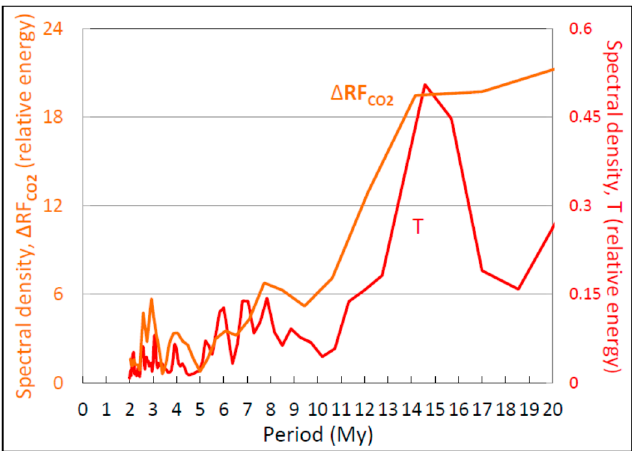
Figure 10. Spectral power periodograms of Δ RF CO2 and T in the Phanerozoic climate. The orange and red curves show Δ RF CO 2 and T spectral density profiles, respectively. The temperature periodogram was constructed using linearly-detrended proxy data. Time periods covered and (in parentheses) Fisher’s Kappa and the corresponding probability that the atmospheric CO 2 concentration and T periodograms result from white (Gaussian) noise are 85 to 0 My (8.26, 0.005) and 522 to 0 My (28.98, 2 × 10 − 13 ), respectively.